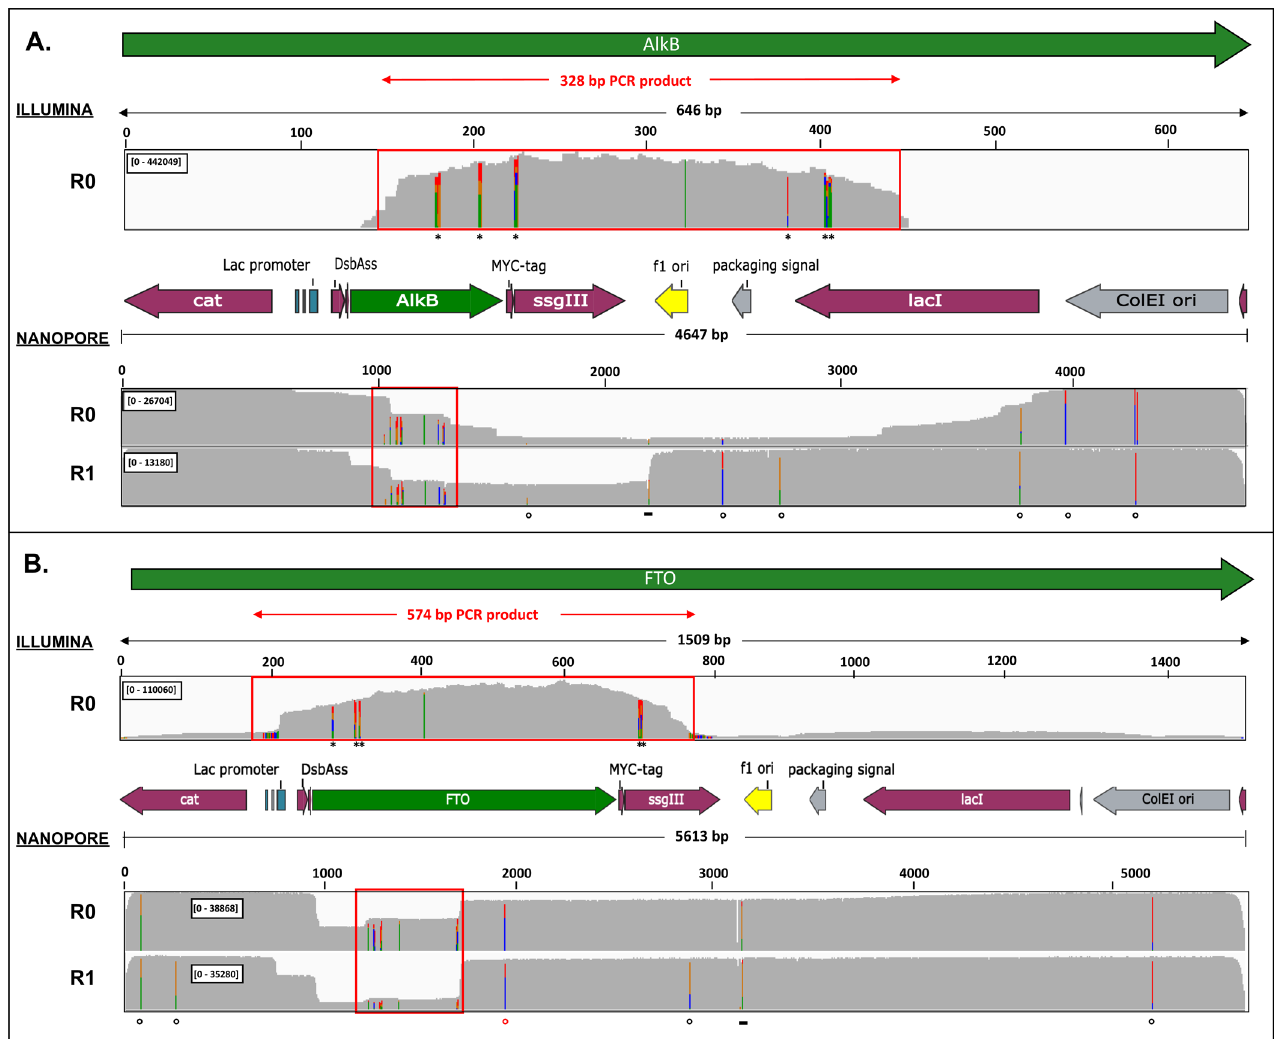
Figure 3. Sequence coverage of Illumina and nanopore sequence reads of the AlkB ( A ) and FTO ( B ) libraries before (R0) and after one selection round (R1). Sequence coverage (gray scale) was obtained after Illumina read processing (quality/adapter trimming, pairing) of PCR-amplified, tagmented target regions (top part of each panel). Nanopore sequence coverage (bottom part of each panel) resulted from the alignment of quality-filtered nanopore reads of ScaI-linearized phagemids to the full display vector reference sequence. Asterisks (*,**) indicate the randomized alkB and FTO target codons. Open black dots represent recurrent substitutions which are assumed to have no functional effects. The open red dot represents a frequent ochre mutation at FTO codon 314. A recurrent short deletion (black bar (-)) is caused by erroneous read-out of a GC-rich region. The Illumina sequencing window is marked by a red box (shown in more detail in Figure S7). Functional features of pDST32-AlkB/FTO vectors are shown as horizontal arrows.